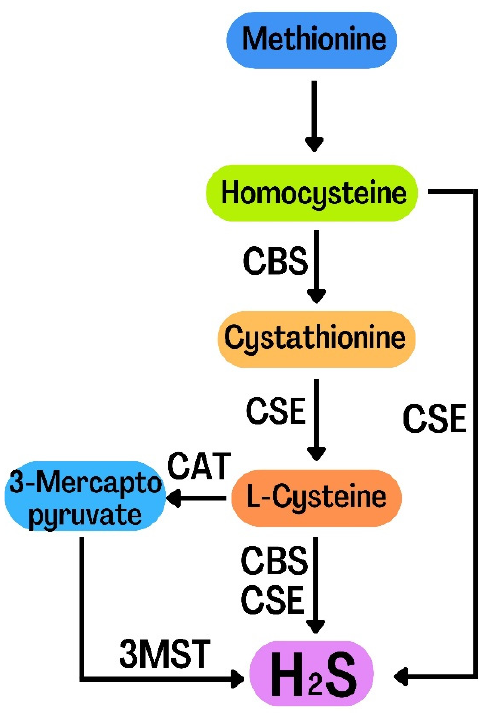
Figure 2. Diagram of the endogenous H 2 S generation process. 4. H 2 S Plays a Protective Role by Regulating Autophagy in Traumatic Brain